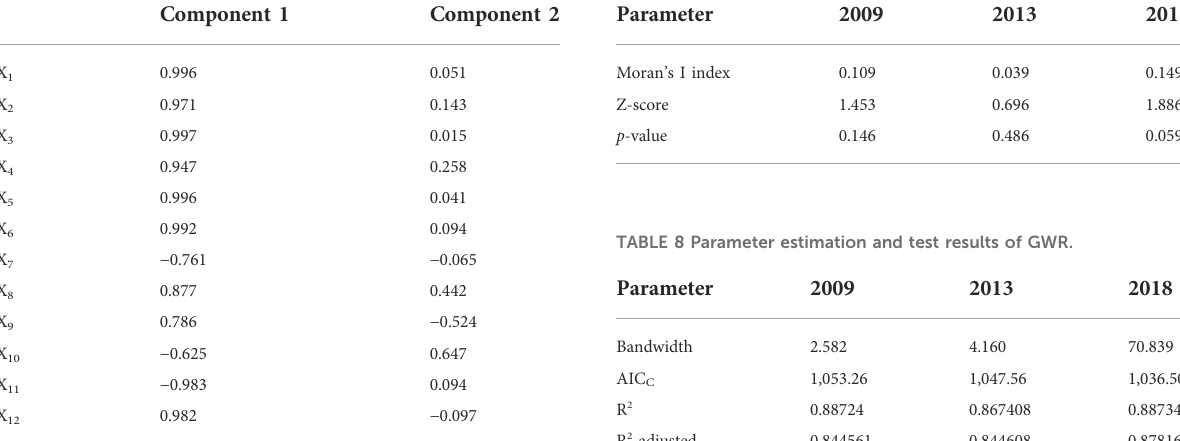
TABLE 5 Component matrix.